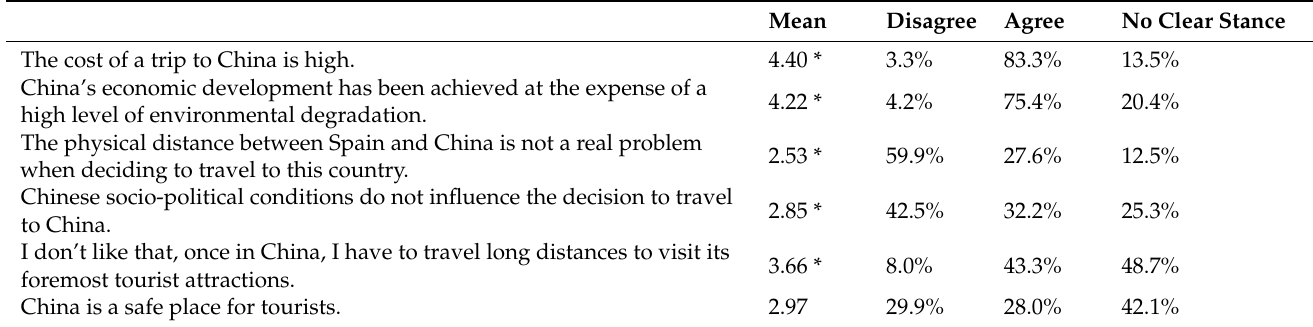
Table 8. Factors inhibiting visits to China (close-ended questions). Mean Disagree Agree No Clear